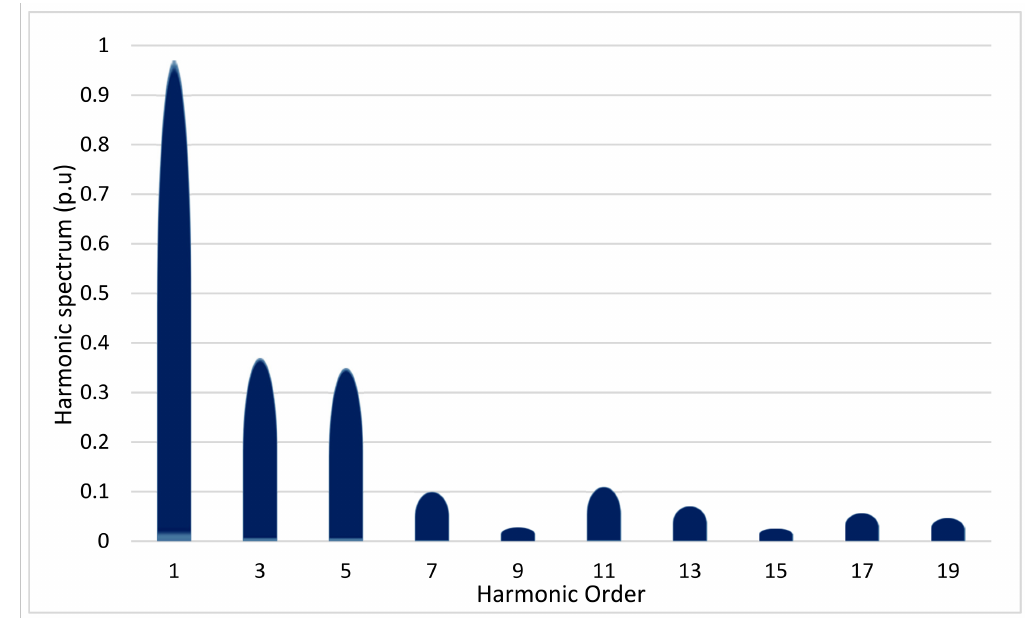
Figure 6. Harmonic current profile.